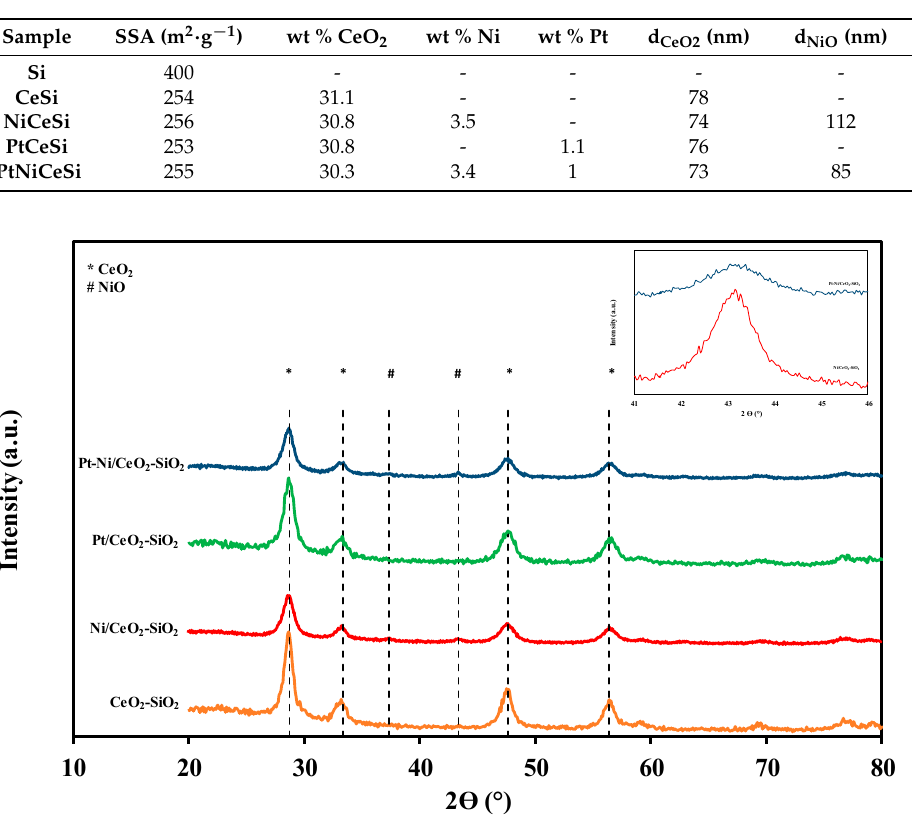
Figure 1. X ‐ ray diffraction (XRD) spectra of calcined support, mono ‐ and bi ‐ metallic catalysts. Figure 1. X-ray diffraction (XRD) spectra of calcined support, mono- and bi-metallic